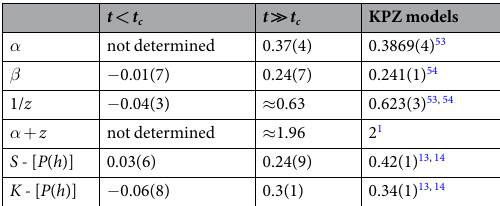
Table 1. Scaling exponents ( α , β and 1/ z ) and HDs’ cumulant ratios ( S and K ) for CdTe/Kapton surfaces at short (2 nd ) and long (3 rd column) deposition times. The rightmost column shows the best known estimates for those quantities obtained from numerical simulations of 2D-KPZ models. For t < t c , the experimental values of S and K are averages, while the ones for t ≫ t c are those for the longest times